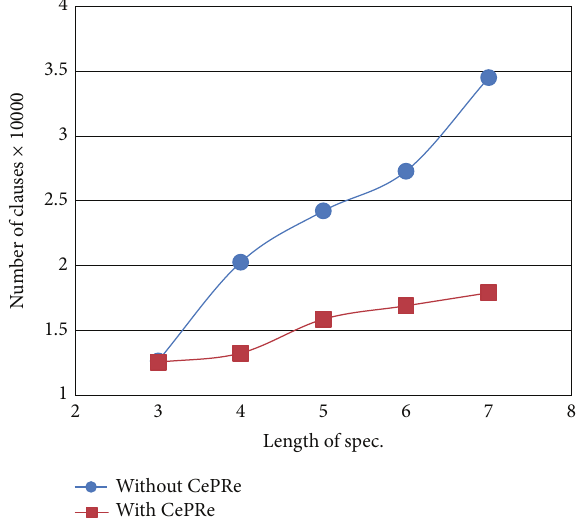
Figure 4: The scale of clauses in random BMC